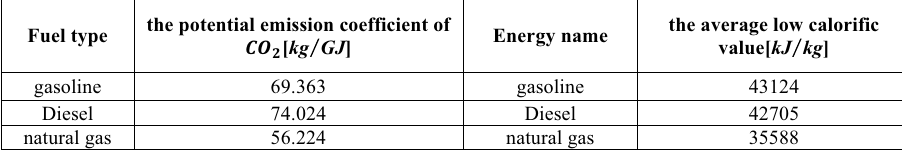
Table 3. The potential emission coefficient and the average low calorific value of CO 2